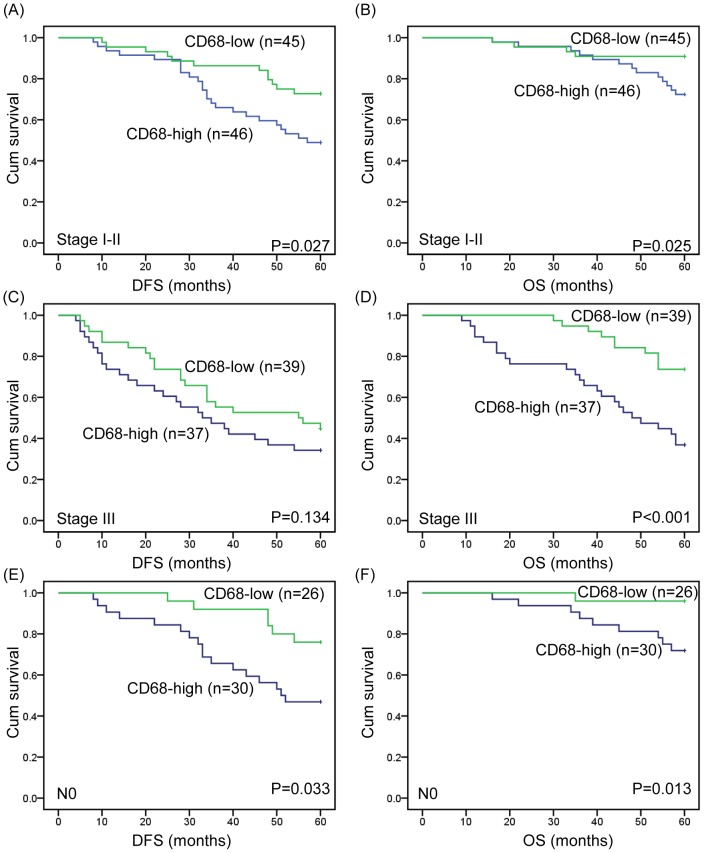
Overall survival and disease-free interval according to clinical stage and lymph node status.(A) DFS in stage I-II patients, P = 0.027 (B) OS in stage I-II patients, P = 0.025 (C) DFS in stage III patients, P = 0.134 (D) OS in stage III patients, P<0.001 (E) DFS in node-negative patients, P = 0.033 (F) OS in node-negative patients, P = 0.013. Green: TAM-low group; Blue: TAM-high group.